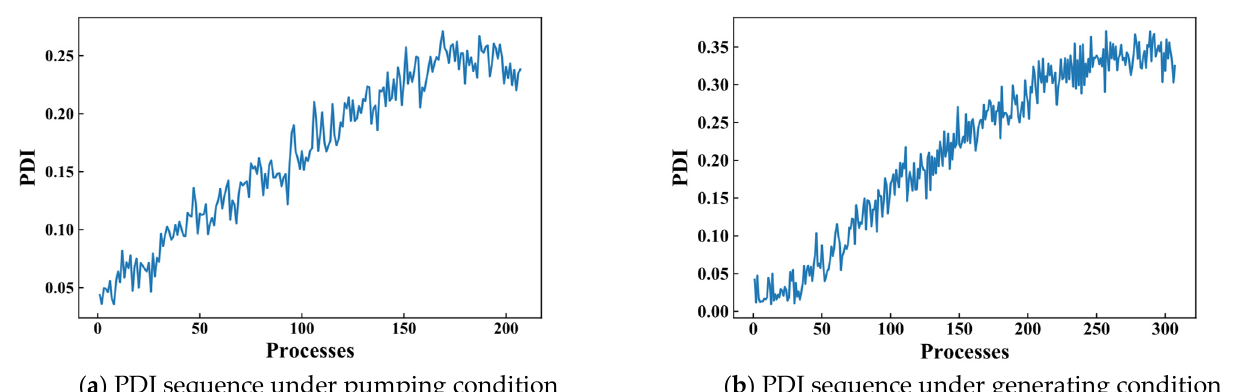
Figure 11. PDI sequences under ( a ) pumping and ( b ) generating conditions.